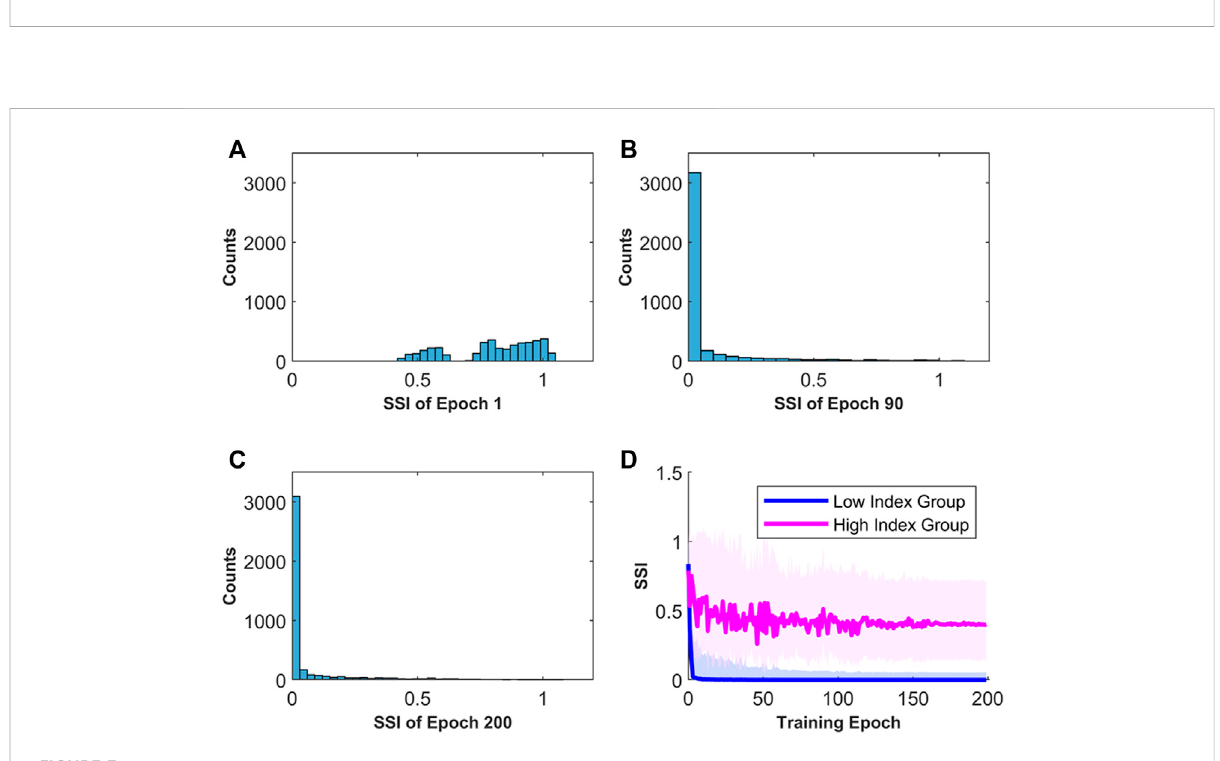
FIGURE 3 Sample Signi fi cance Index distribution along the training epochs. (A) SSI distribution at epoch 1. (B) SSI distribution at epoch 90. (C) SSI distribution at epoch 200. (D) Median SSI curve for the low- and high-index groups. The light-colored area shows the 10 – 90% quantiles of the